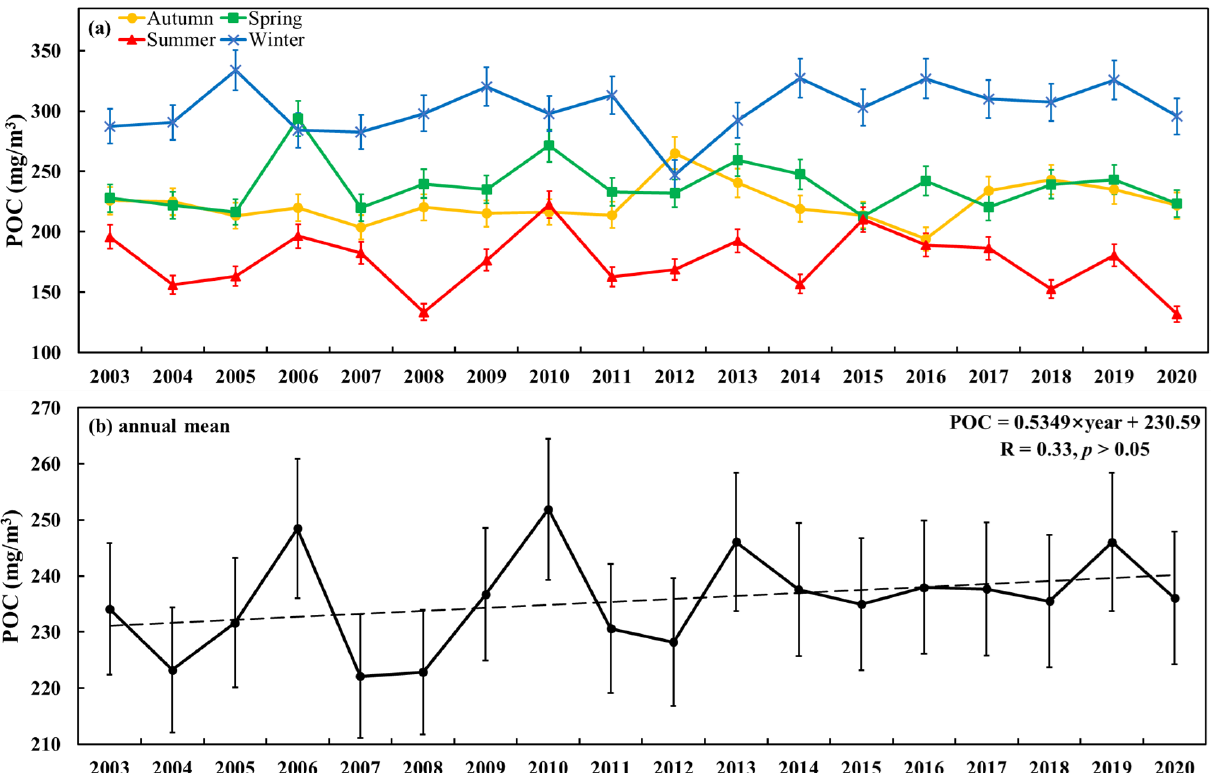
Figure 4. Variations in POC mean concentrations in the East China Sea on a seasonal ( a ) and yearly ( b ) scale (The black dotted line represents the trend line of POC and year).